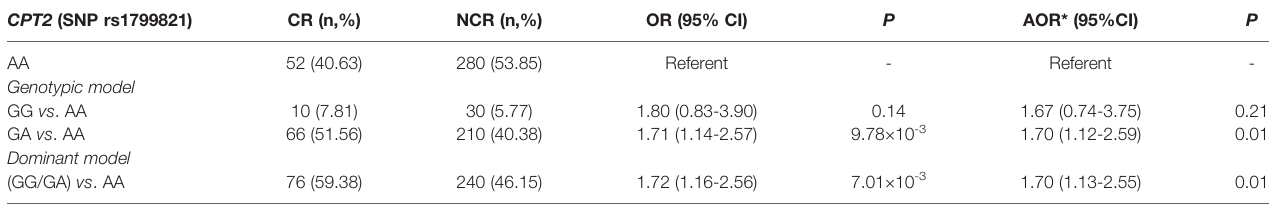
TABLE 3 | Association of carnitine palmitoyltransferase 2 ( CPT2 ) genotypes with complete response. CPT2 (SNP rs1799821)